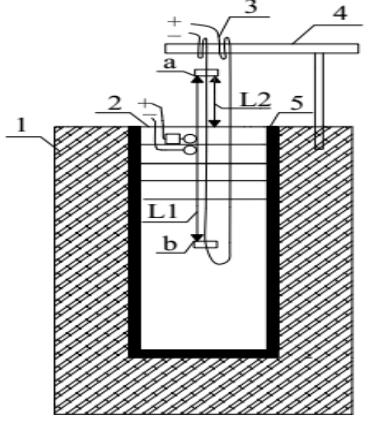
Figure 1. Icing simulation device: (1) Expanded polystyrene (EPS) insulation; (2) Heating sheet; (3) Device for measuring ice thickness; (4) T-shaped bracket; (5) Glass cylindrical barrel.